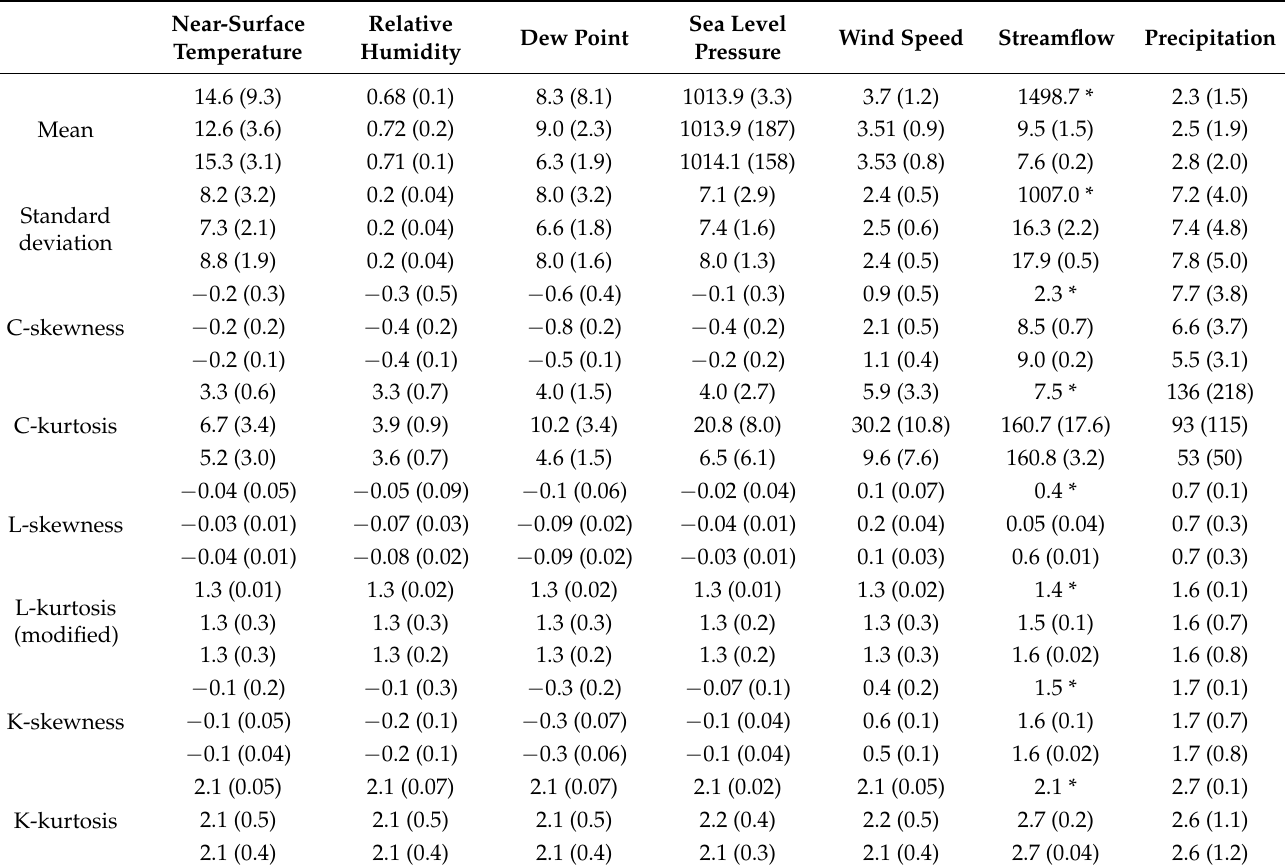
Table 2. Summary Statistics of the Mean Values of the C-, L-, and K-Moments (and Their Standard Deviation in Parentheses) for Time Series Lengths of N ≥ 60 Years (1st Row), 30 < N < 60 (2nd Row) and N ≤ 30 (3rd Row).